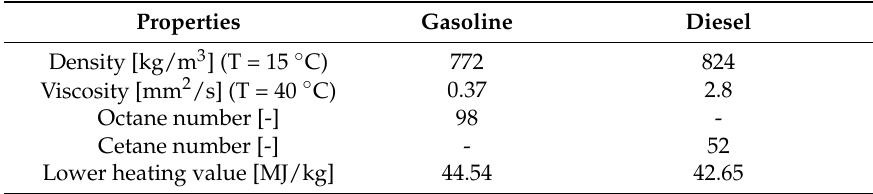
Table 3. Physical and chemical properties of the fuels used along the study.